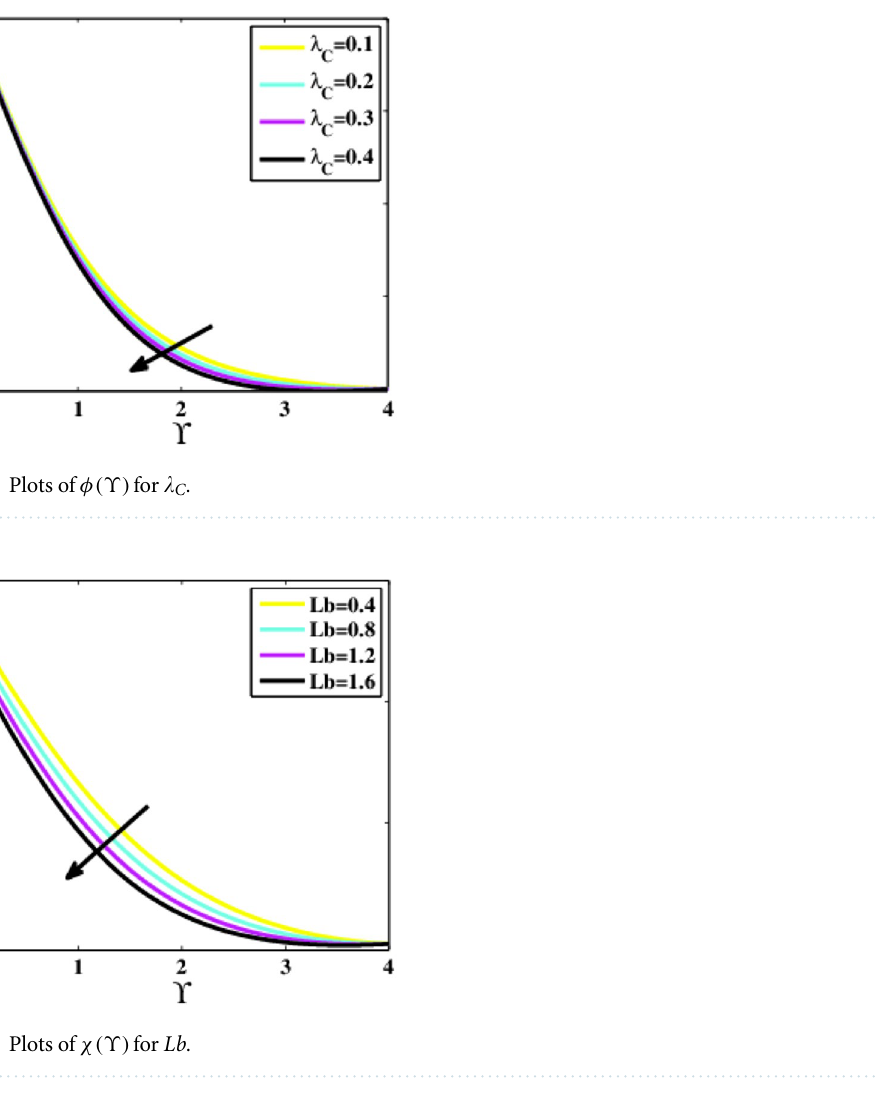
∗ Figure 23 captures the impression of the chemical reaction factor σ on the concentration profile φ(ϒ) . The ∗ ∗ profile φ(ϒ) is decreasing for growing values of the parameter σ . When the parameter σ increases, the number of solute molecules involved in the reaction increases, lowering the concentration. As a result of the destructive chemical reaction, the solutal boundary layer’s thickness is considerably reduced. Figure 24 indicates the effects of the relaxation time of the mass parameter (cid:31) C upon the dimensionless con- centration profile φ(ϒ) . The profile φ(ϒ) reduces as the parameter (cid:31) C surges. It is because if the parameter (cid:31) C is larger, then the particles of the fluid will take longer to disperse, resulting in a decrease in the concentration profile. Figure 25 is plotted to predict the effects of the bio-convection Lewis number Lb upon the dimensionless profile of microorganisms χ(ϒ) . It is noticed that the profile χ(ϒ) observe to decrease for higher Lb . Physically, the parameter Lb is inversely proportional to the thermal diffusivity; raising Lb lessens the thermal diffusivity, resulting in a decrease in the motile density of microorganisms. Figure 26 is delineated to determine the effects of the Peclet number Pe on the non-dimensional microor- ganisms profile χ(ϒ) . It is perceived that the profile χ(ϒ) is decaying for greater estimations of the parameter Pe . Physically, the parameter Pe is inversely linked with the diffusivity of the microorganisms and has a direct association with cell swimming speed. Consequently, an increase in Pe increases cell swimming speed while reducing microbe diffusivity. As a result, the microorganism’s ability to develop Pe is reduced. Figure 27 demonstrates the impression of the Biot number of microorganisms γ 3 on the non-dimensional profile of the microorganisms χ(ϒ) . The profile χ(ϒ) escalates for rising values of the parameter γ 3 . A dramatic increase from γ 3 = 0.1 to γ 3 = 0.2 is noticed.